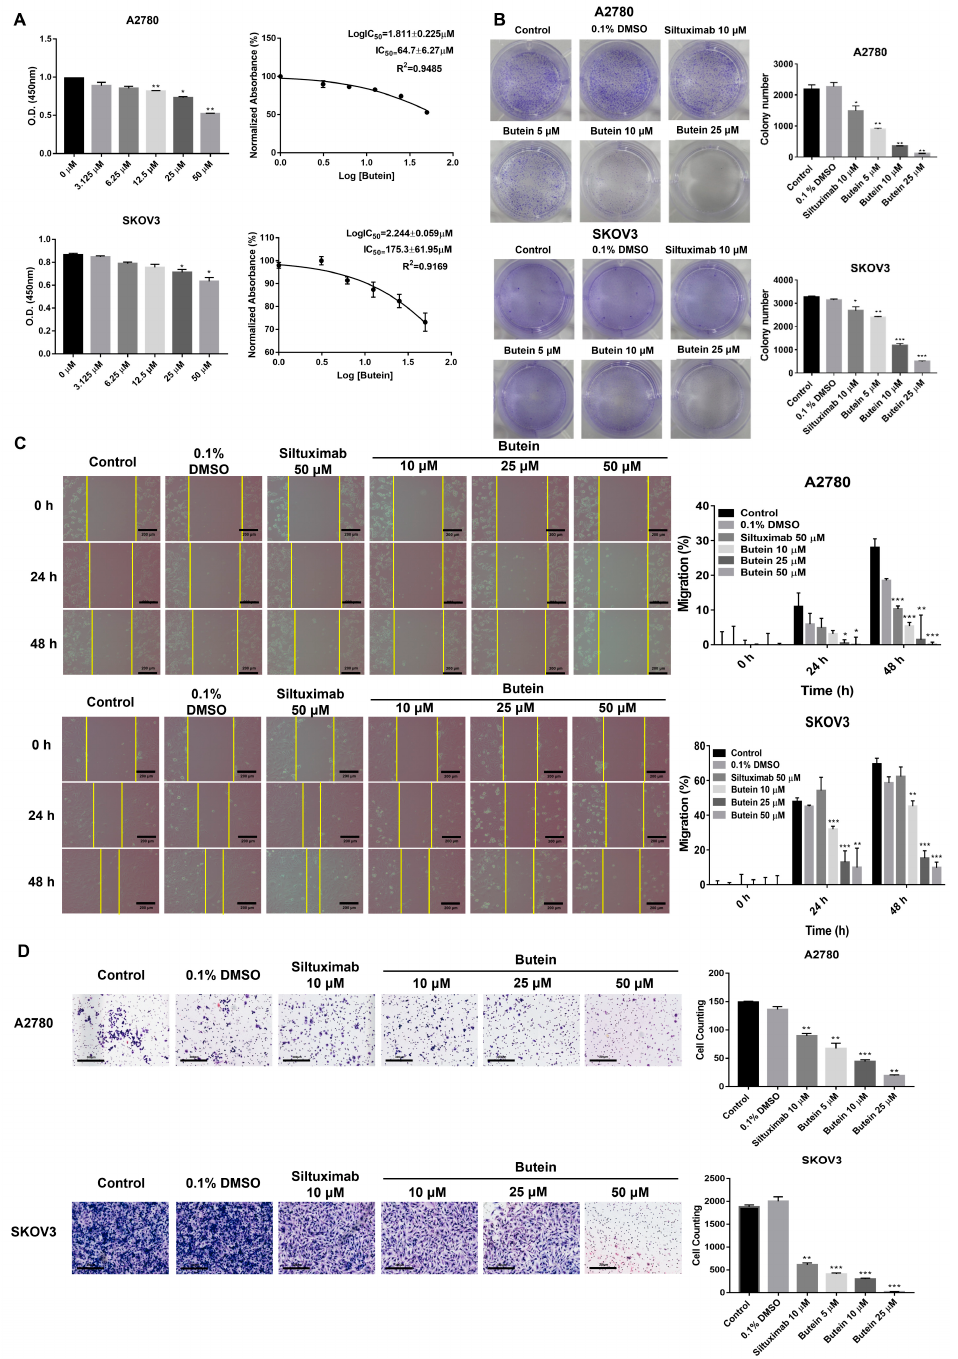
Figure 3. Butein inhibited cell viability, proliferation, migration, and invasion of ovarian cancer cells. ( A ) A2780 and SKOV3 cells were treated with butein at the indicated concentrations in triplicate for 48 h and processed for MTT assay to analyze cell viability (* p < 0.05, ** p < 0.01). ( B ) Clonogenic assay revealed that butein dramatically reduced the colony growth of ovarian cancer cells (* p < 0.05, ** p < 0.01, *** p < 0.001). ( C ) A2780 and SKOV3 cells were treated with butein and allowed to migrate to the scratched area for 24 h and 48 h. Yellow color lines indicate a gap in the scratched area. The percentage of migrating area in the wound-healing assay quantified in A2780 and SKOV3 cells is shown (* p < 0.05, ** p < 0.01, and *** p < 0.001). ( D ) Matrigel invasion assay was used to determine the invasion of A2780 and SKOV3 cells after 48 h of butein treatment. Bars indicate mean ± standard deviation of three independent experiments performed in triplicate (** p < 0.01 and *** p <